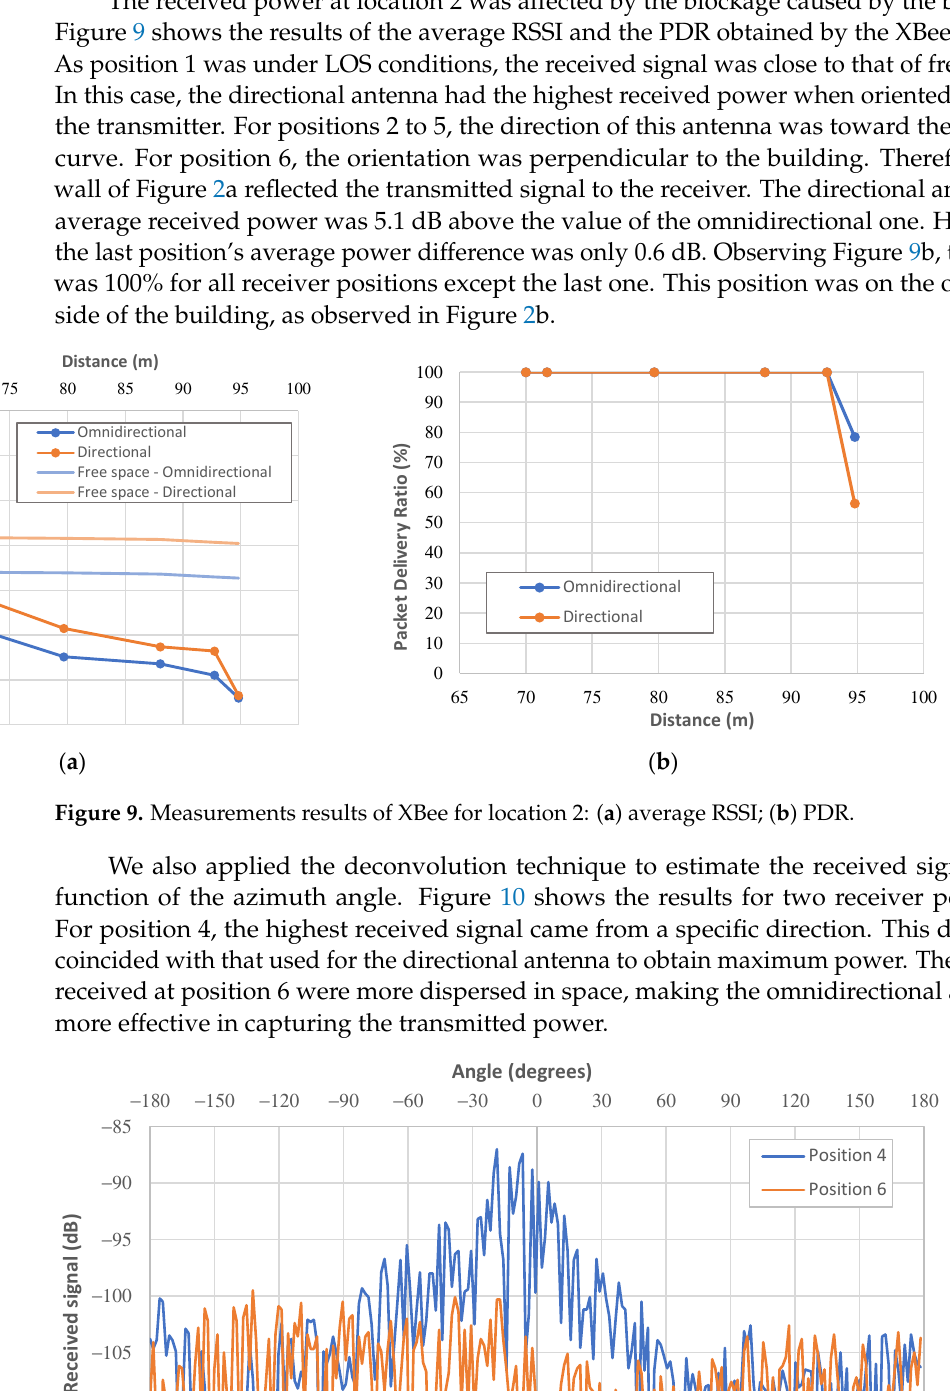
( b ) Figure 11. RSSI measurements: ( a ) omnidirectional antenna; ( b ) directional antenna.